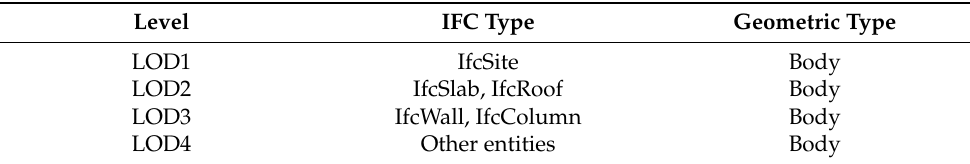
Table 2. Hierarchical level of detail (LOD) for Building Information Modeling (BIM) models.